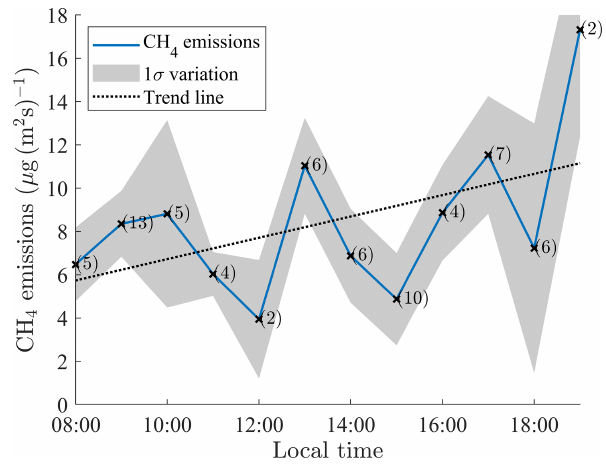
Figure 11. Daily variations in the emissions from Oktoberfest be- tween 08:00 and 19:00 local time. The grey shaded area denotes the uncertainty (1 σ standard deviation) within that hour. The numbers in parentheses indicate the number of valid plumes during that